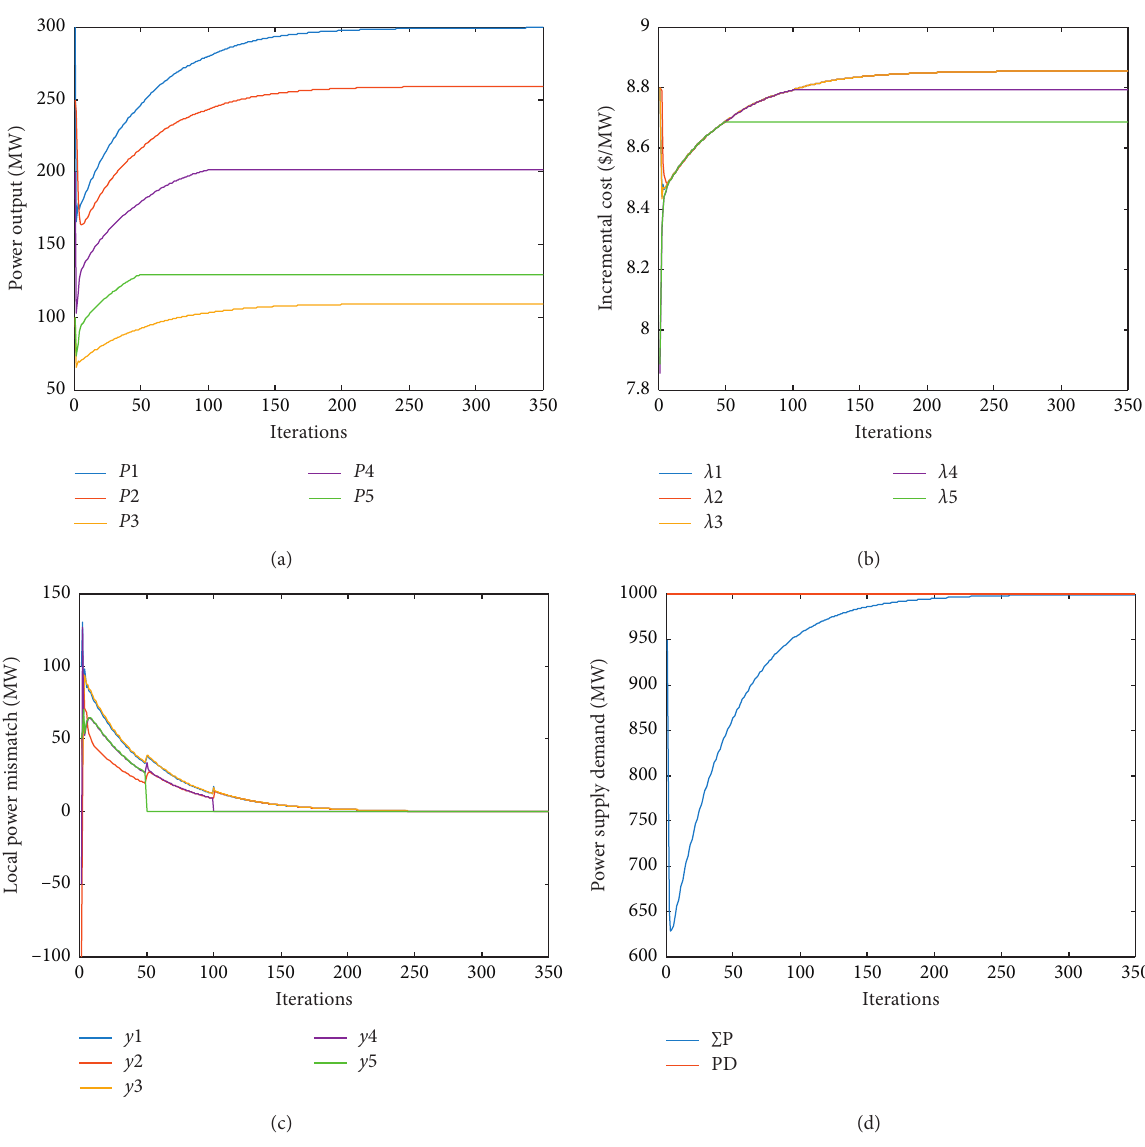
Figure 5: EDP with disconnected topology under DoS attacks. (a) The power output of each generator. (b) The incremental cost of each generator. (c) Auxiliary variable y of each generator. (d) Total power output and load